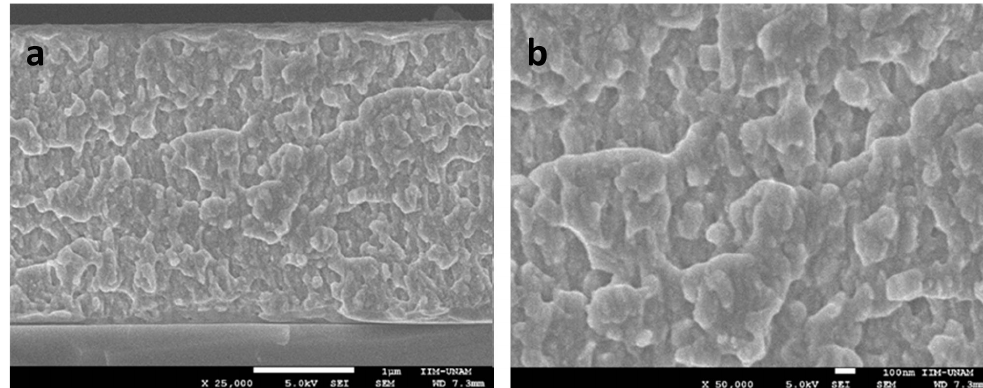
Figure 5. Cross-section SEM image of M4 coating. a) 25000X, b)